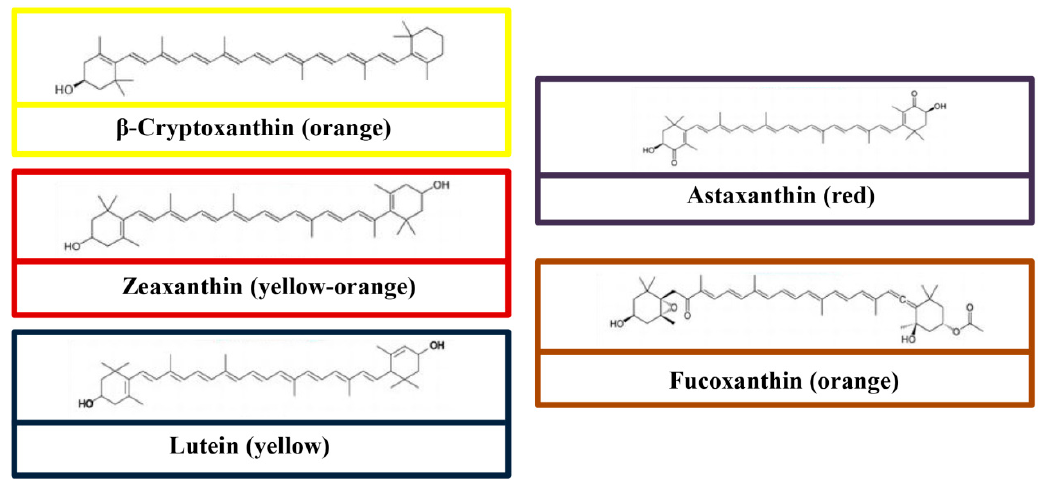
Figure 2. Molecular structures of some common xanthophylls ( β -cryptoxanthin, zeaxanthin, lutein, astaxanthin, and fucoxanthin).